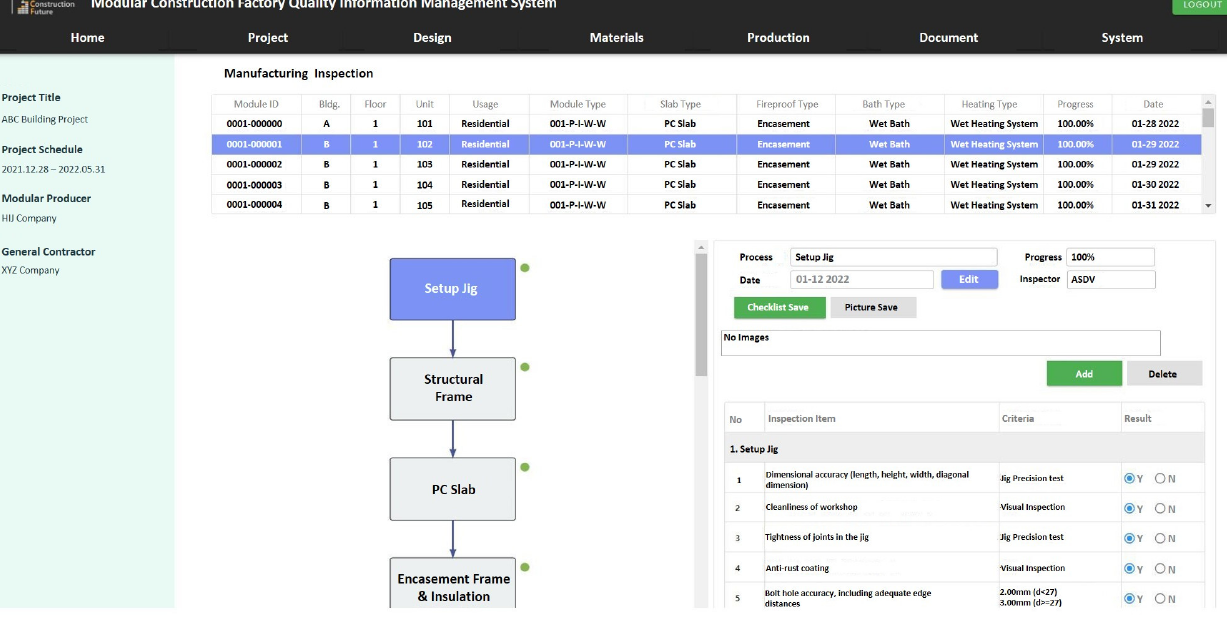
Figure 8. Module production inspection